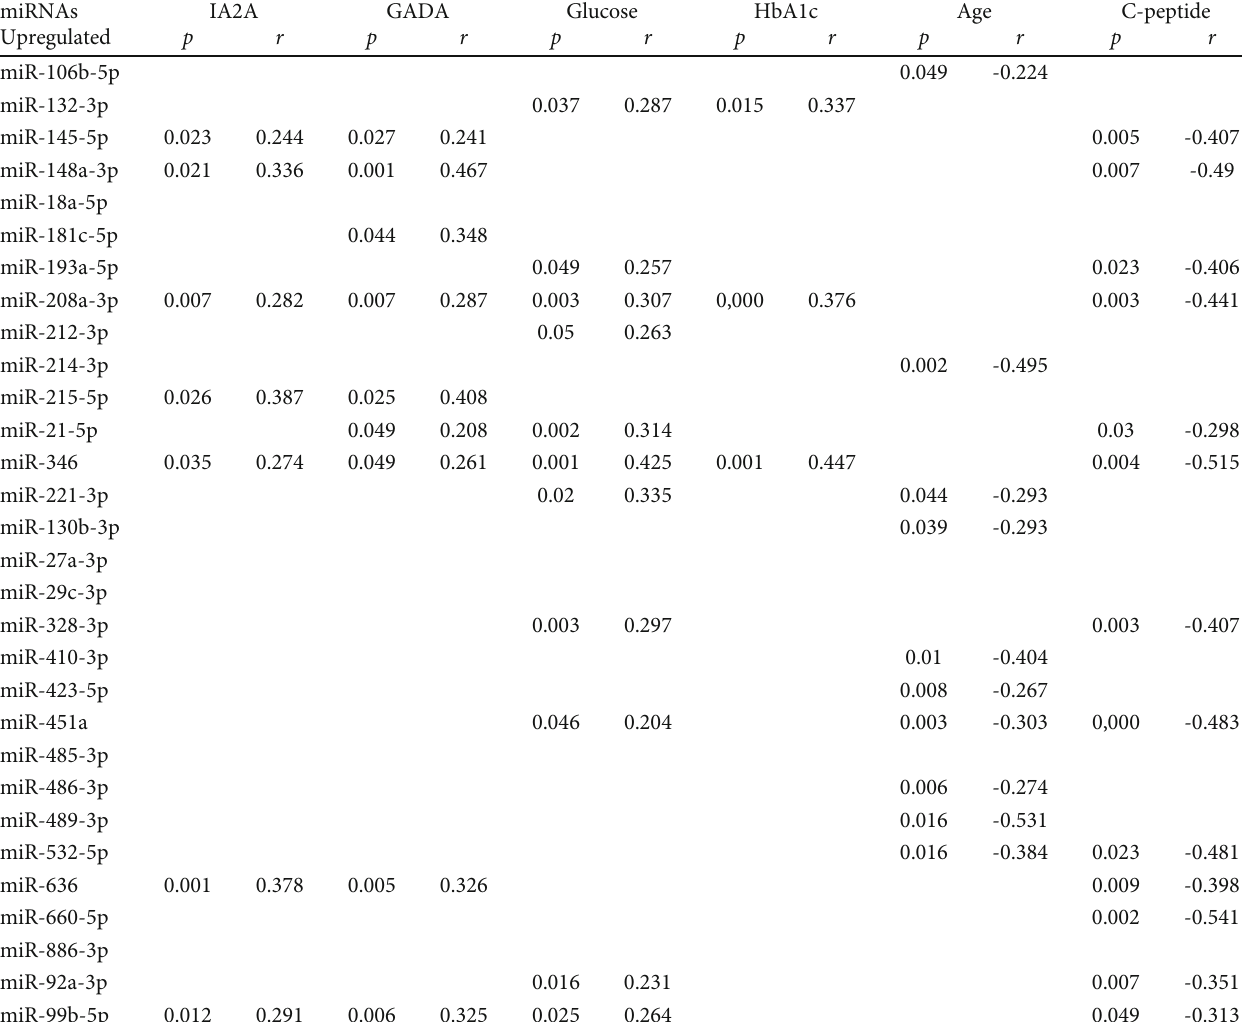
Table 5: Correlations of upregulated miRNAs from cluster B.